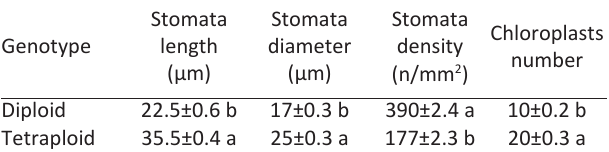
Table 2 - Mean of stomata size, density and chloroplast num- bers in diploid and tetraploid plants of C. roseus